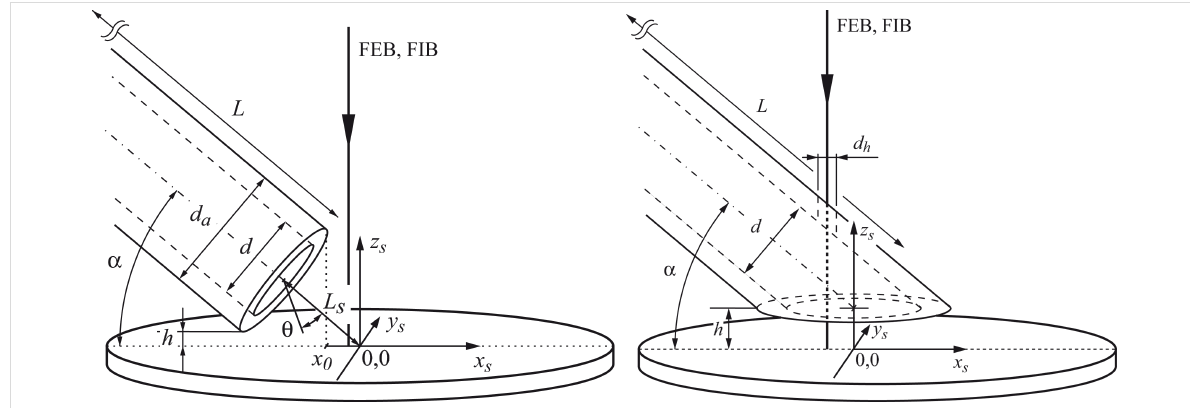
Figure 6: Illustration of the two capillary nozzle geometries implemented in the GIS simulator. Left: straight capillary; right: bevelled capillary. Modi- fied from [31].